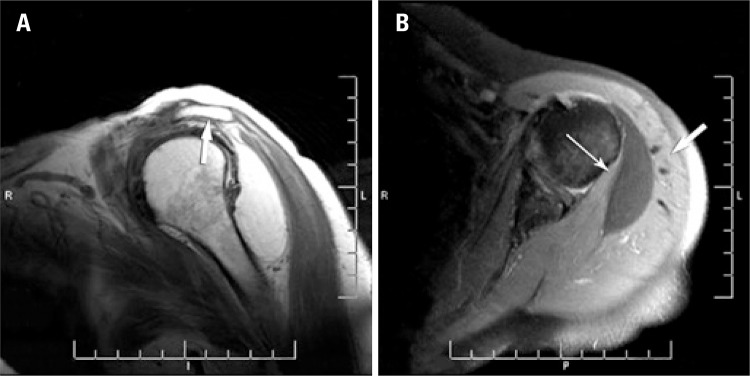
(A) Corte sagital mostra lipoma subdeltoide, que não invade o espaço subacromial, e redução do tendão do supraespinhoso (seta). (B) Lipoma entre os músculos redondo menor (seta estreita) e deltoide (seta larga)